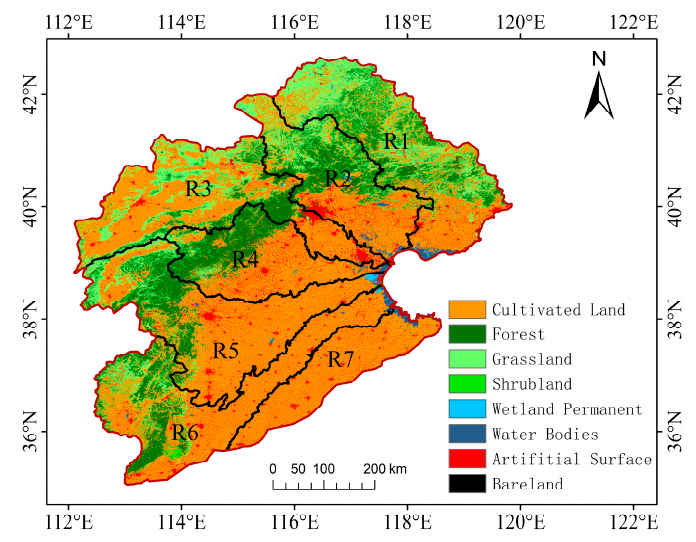
Figure 2. Map of land cover types in 2010.